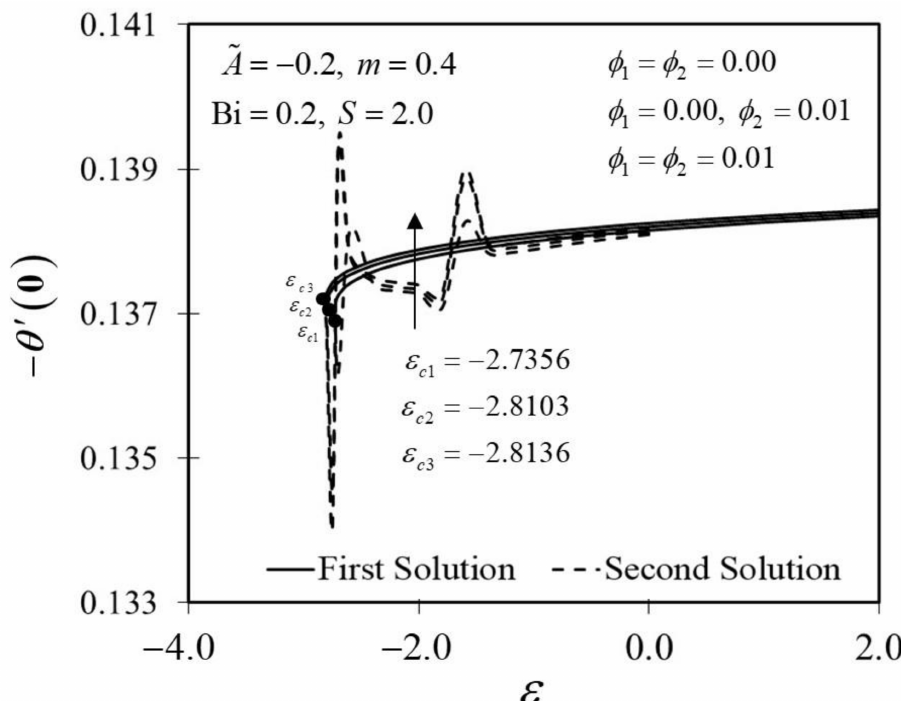
Figure 3. Trend of − θ (cid:48) ( 0 ) with ε and assorted φ